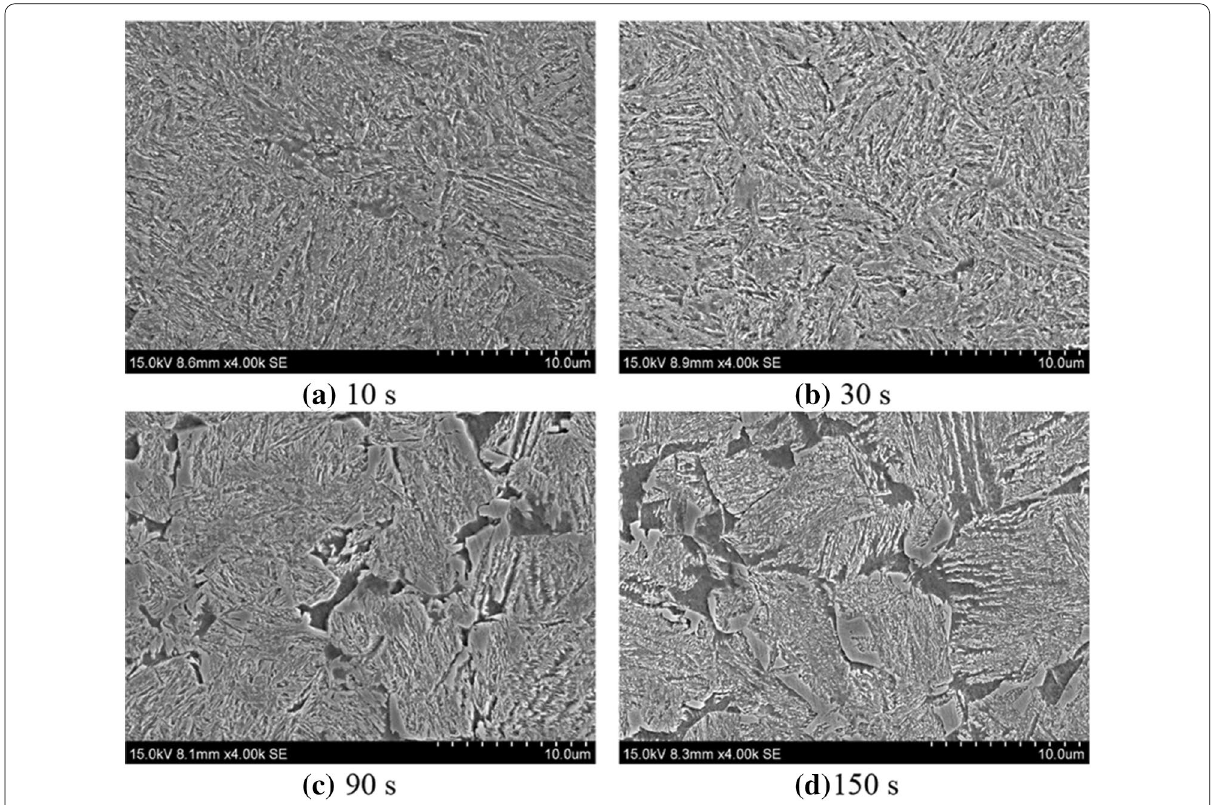
Figure 12 SEM micrographs of D-Q-P-T samples prepared using different tempering